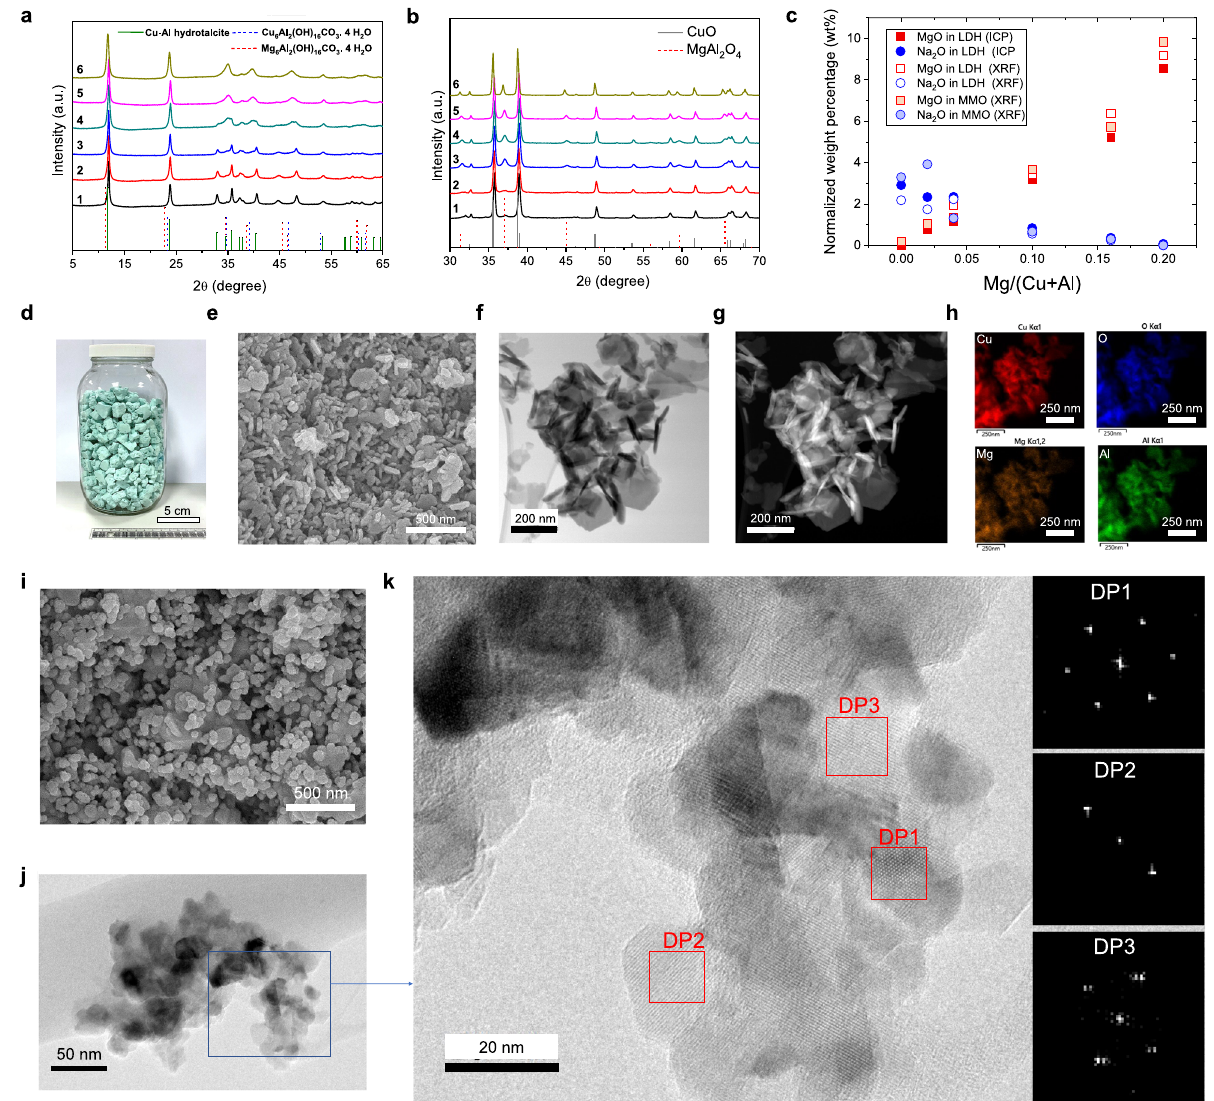
Fig. 2 | Synthesis and characterization of CuMgAl-LDH precursors and derived MMOs. a XRD patterns of CuMgAl-LDHs and b , CuMgAl-MMO. The crystalline pattern in a corresponds to CuAl hydrotalcite (JCPDS 46-0099, 37-0360; vertical lines), and MgAl hydrotalcite Mg 6 Al 2 (OH) 16 CO 3 ·4 H 2 O (JCPDS 22-0700; vertical dashedlines).Crystallinepatternsin b correspondtoCuO(JCPDS80-1268;vertical lines) and MgAl 2 O 4 (JCPDS 73-1959, vertical dashed lines), respectively. The apparent Cu:Mg:Al molar ratio for samples in a and b : (1) 3:0:2, (2) 3:0.1:2, (3) 3:0.2:2, (4) 3:0.5:2, (5) 3:0.8:2, (6) 3:1:2. c normalized weight percentage of Na 2 O